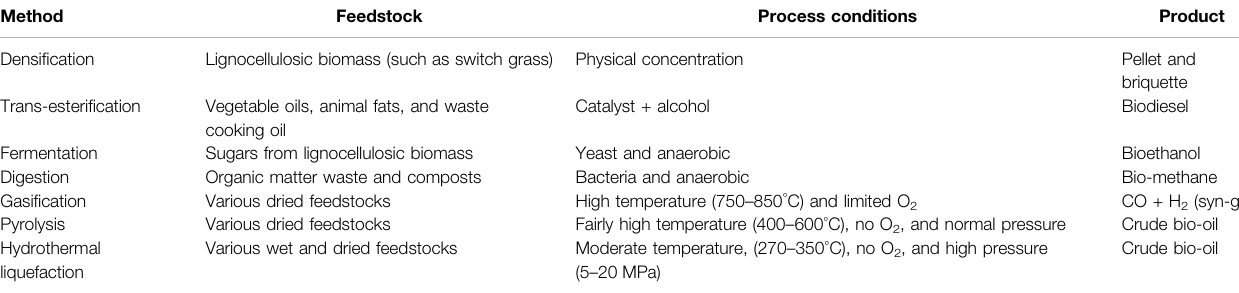
TABLE 6 | Biowaste conversion technologies based on feedstock types, process requirements, and target